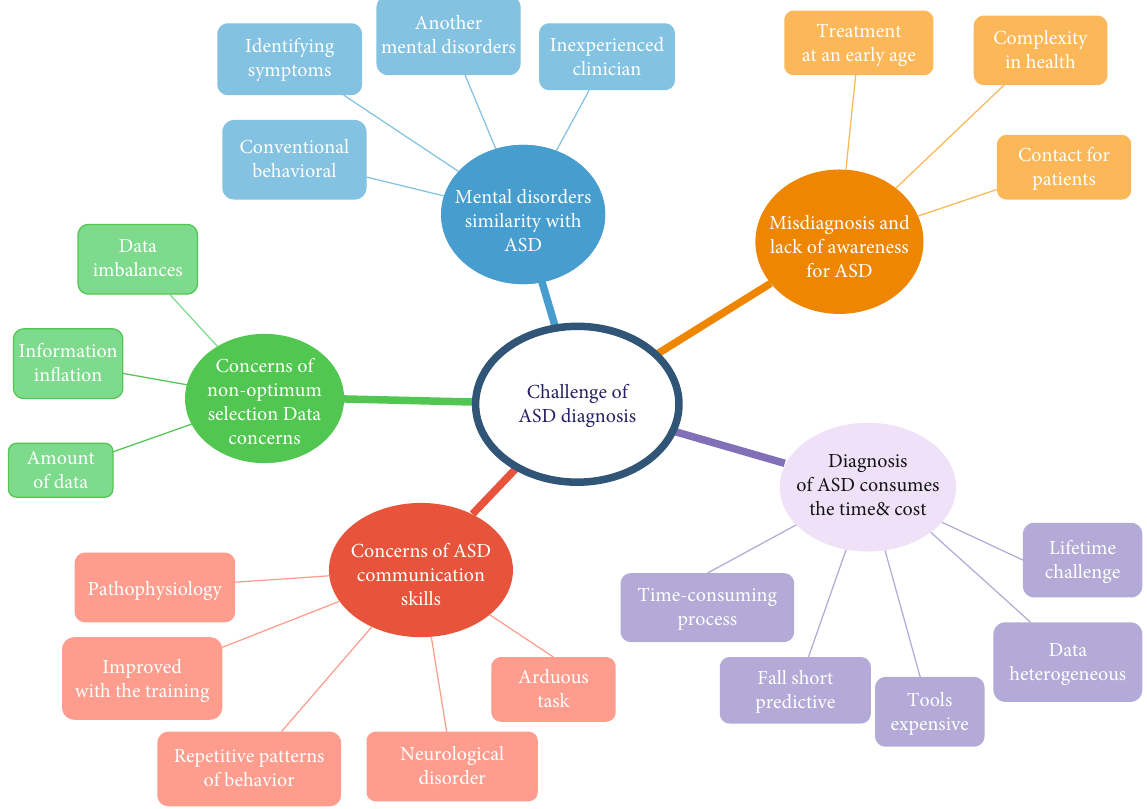
Figure 9: Challenges of ASD